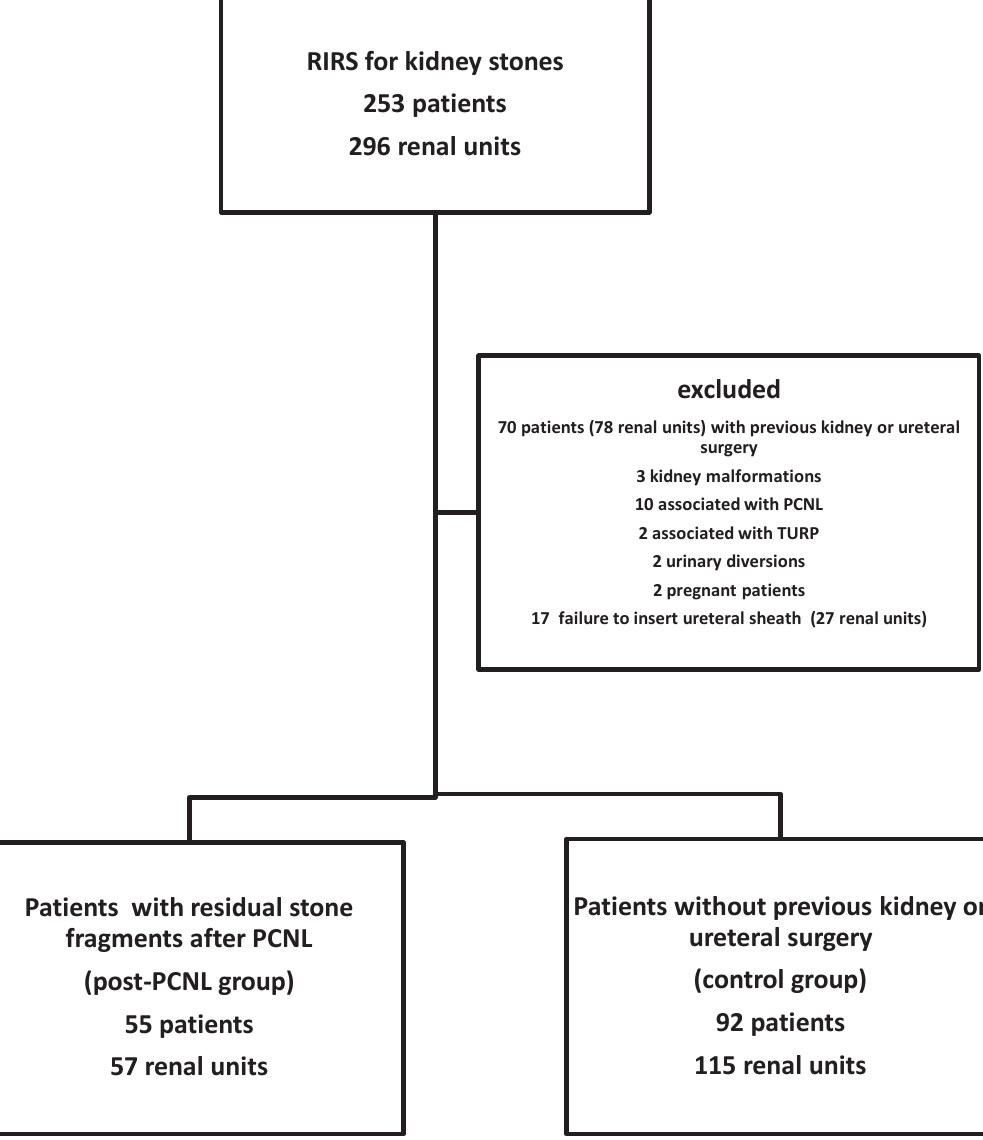
Figure 1 - Flow diagram of the enrollment of participants in the